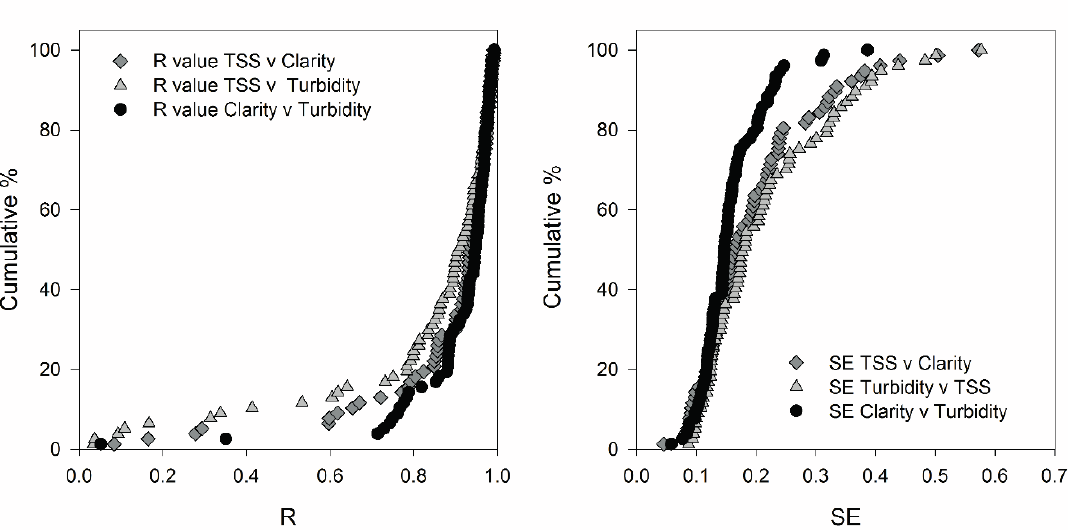
Fig. 3 Distribution plots of the Pearson’s correlation coefficient, R , and standard error (SE) of the regressions for TSS vs visibility, TSS vs turbidity and visibility vs